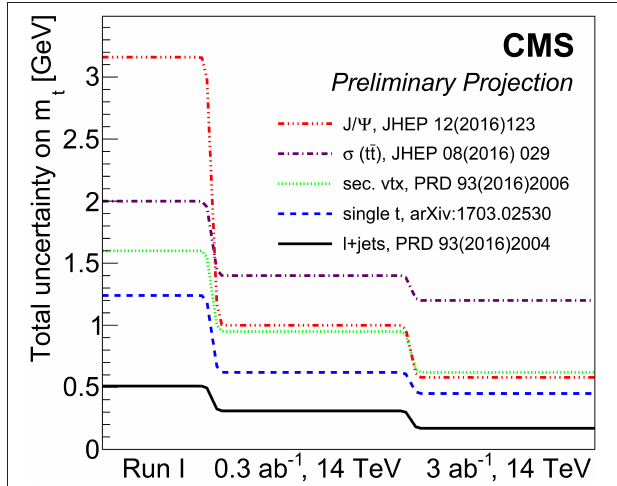
FIGURE 2 | Projections of the uncertainty on the top-mass determination for different strategies, according to the CMS Collaboration, as a function of the integrated luminosity at